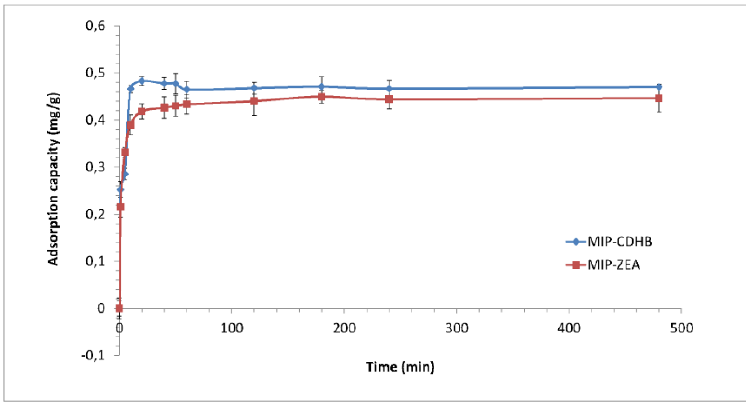
Figure 10. Zearalenone adsorption capacity of MIP-CDHB and MIP-ZEA.